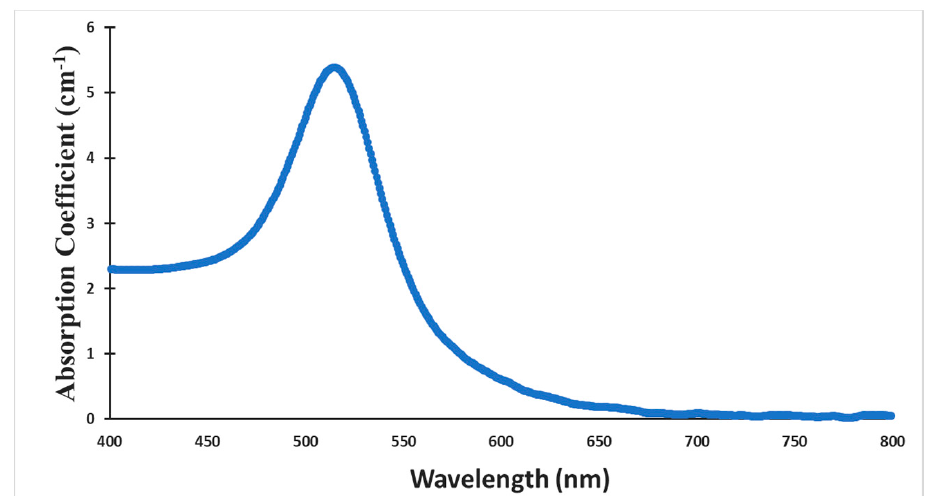
Figure 1. Experimental set-up for measurement of electroabsorption.